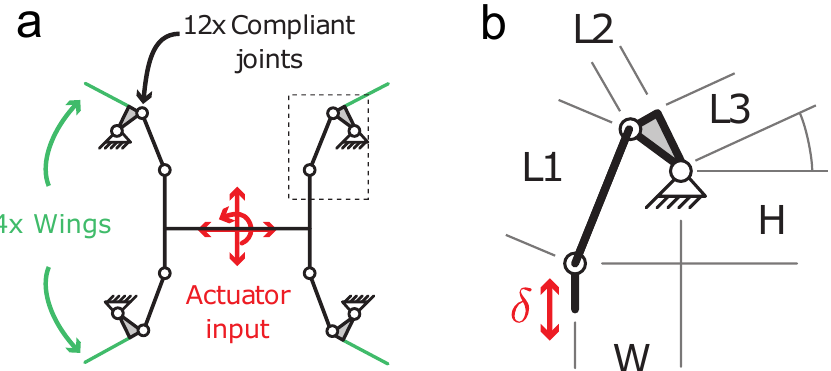
Figure 3. Kinematics and assembly of a compliant “thorax”. ( a ) Quad-four-bar linkage system that transmits linear actuation to rotational wing motion. White circles indicate flexure joints, green lines indicate wing locations, and the linkage is fixed to the chassis on the sides. ( b ) Details of the linkage, L 1 = 4.2 mm, L 2 = 2.0 mm, L 3 = 0.8 mm, W = 3.0 mm, H = 3.13